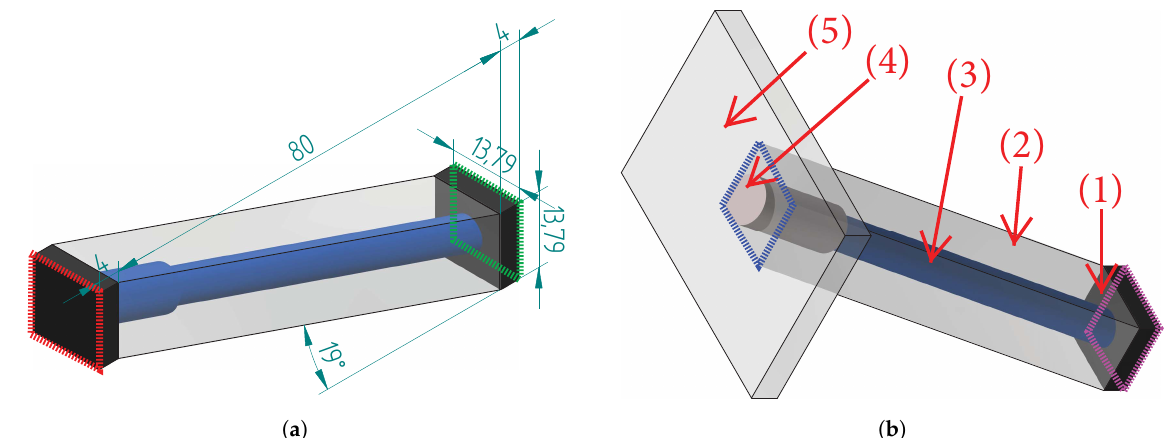
Figure 5. Geometries of the investigated SATIS models in state 2 and state 3. ( a ) Geometry of the SATIS model in state 2. The nominal lengths given are in millimeters. ( b ) Geometry of the SATIS model in state 3. Assignment of numbers (1) through (5) to the materials and their properties is listed in Table 3. Table 3. The materials, material properties and boundary conditions used for the SATIS models in state 2 and state